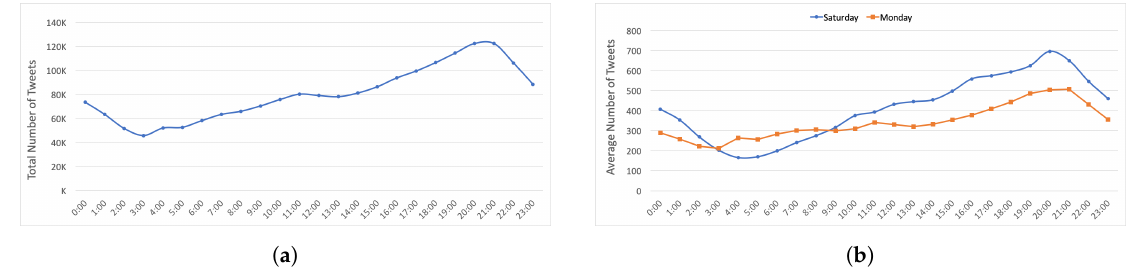
Figure 5. Tweets posted per hour ( a ) general tweet distribution ( b ) tweet distribution on Saturday and Monday.